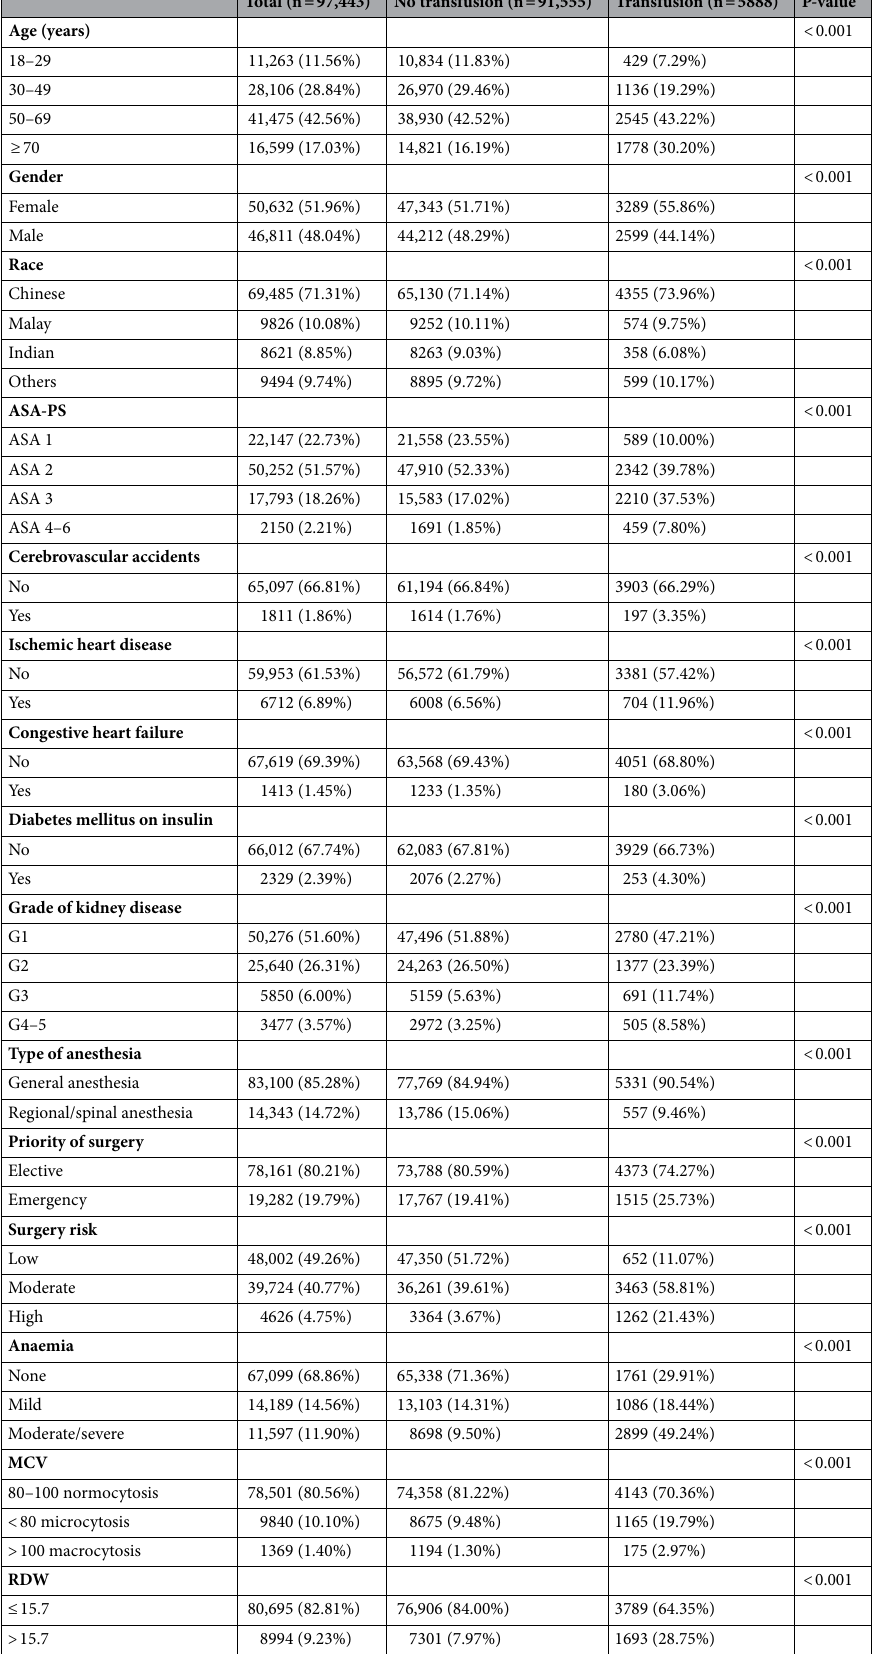
Table 1. Baseline of patients in no transfusion and transfusion